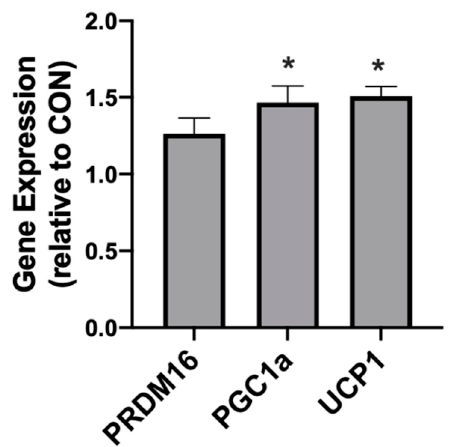
Figure 7. A ketogenic diet alters the mitochondrial-related gene expression in rodent subcutaneous adipose. Following the 28-day diet intervention, subcutaneous adipose was harvested and the expression of PRDM16, PGC1 α , and UCP1 was quantified. n = 6. * p < 0.05.